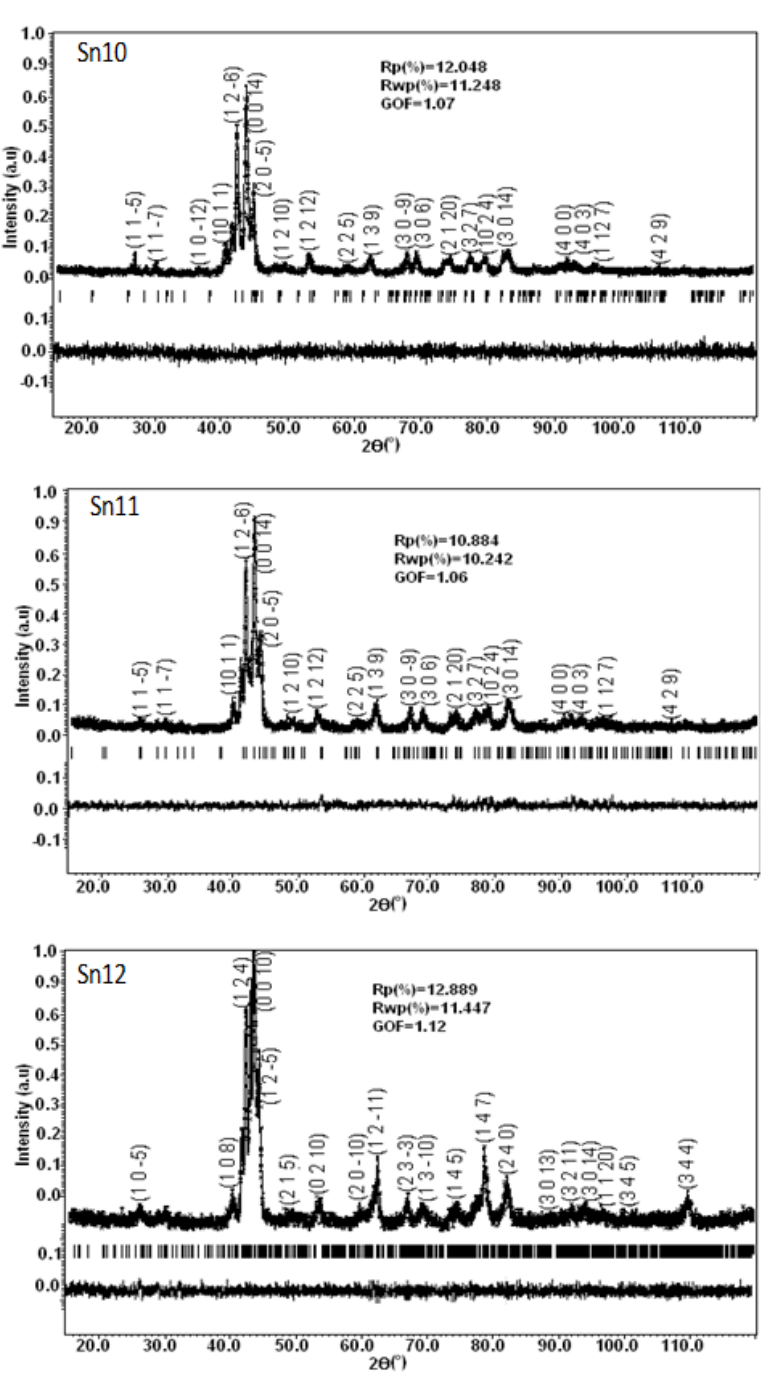
Figure 1. X-ray diffraction patterns (room temperature) for samples labeled as Sn10, Sn11, and Sn12. The crystallographic structure is identified as monoclinic 7M for Sn10 and Sn11 and 10M for Sn12.